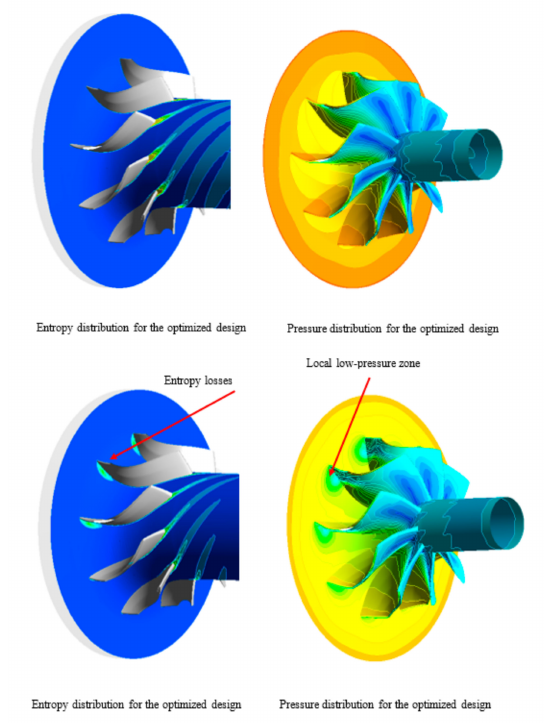
Figure 17. Entropy and pressure contours on 50% span for the base and optimized